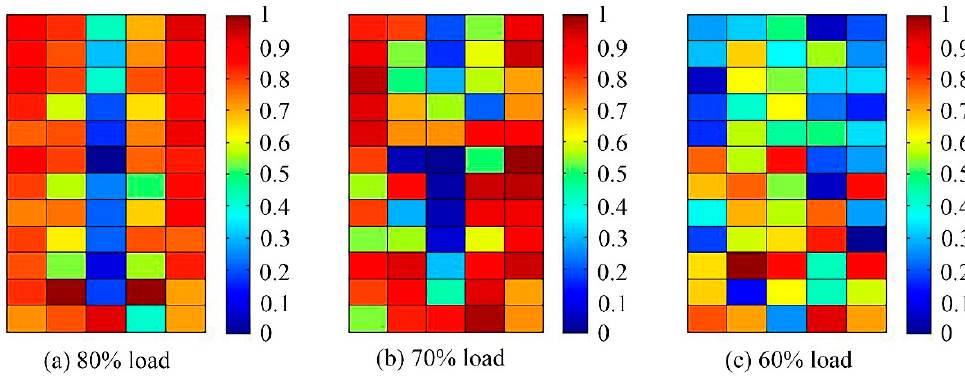
Figure 19. Load distribution hazard model for steel storage racks with bracings.